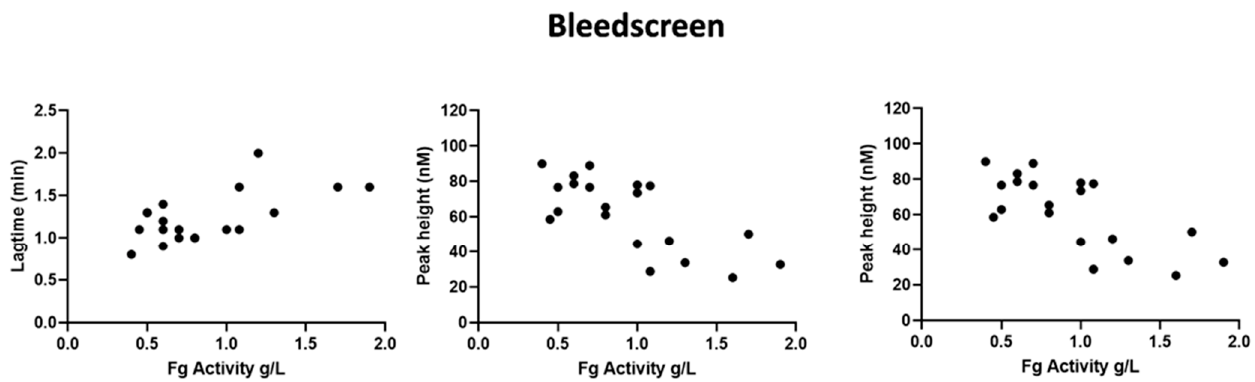
Figure 4. Correlation of TG variables with STG-BLS (bleedscreen) with fibrinogen activity. The data are shown TG values are shown for 19 patients as follows: asymptomatic n = 13; bleeding n = 4, thrombosis n = 2; hypofibrinogenemia n = 8; dysfibrinogenemia n = 8; and hypodysfibrinogenemia n = 3.